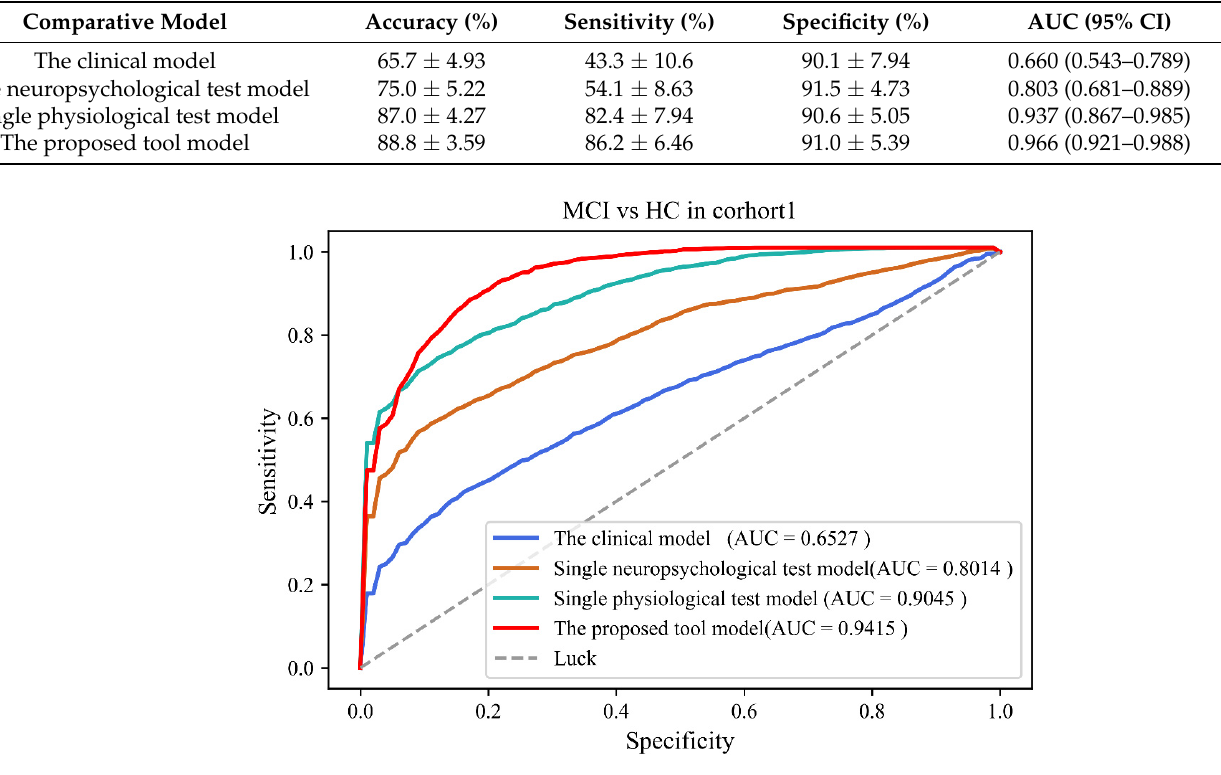
Table 4. The classification results of four models in cohort 2.